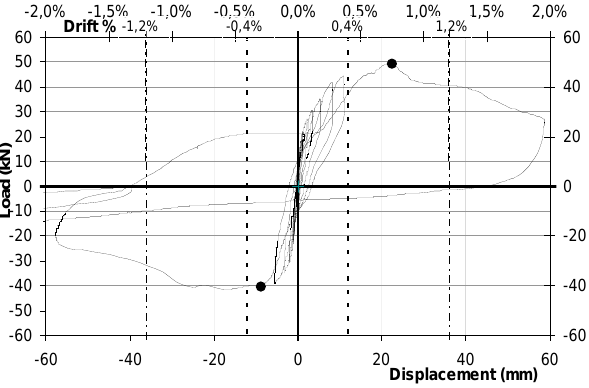
Figure 7 Reference infilled frame RISPS2